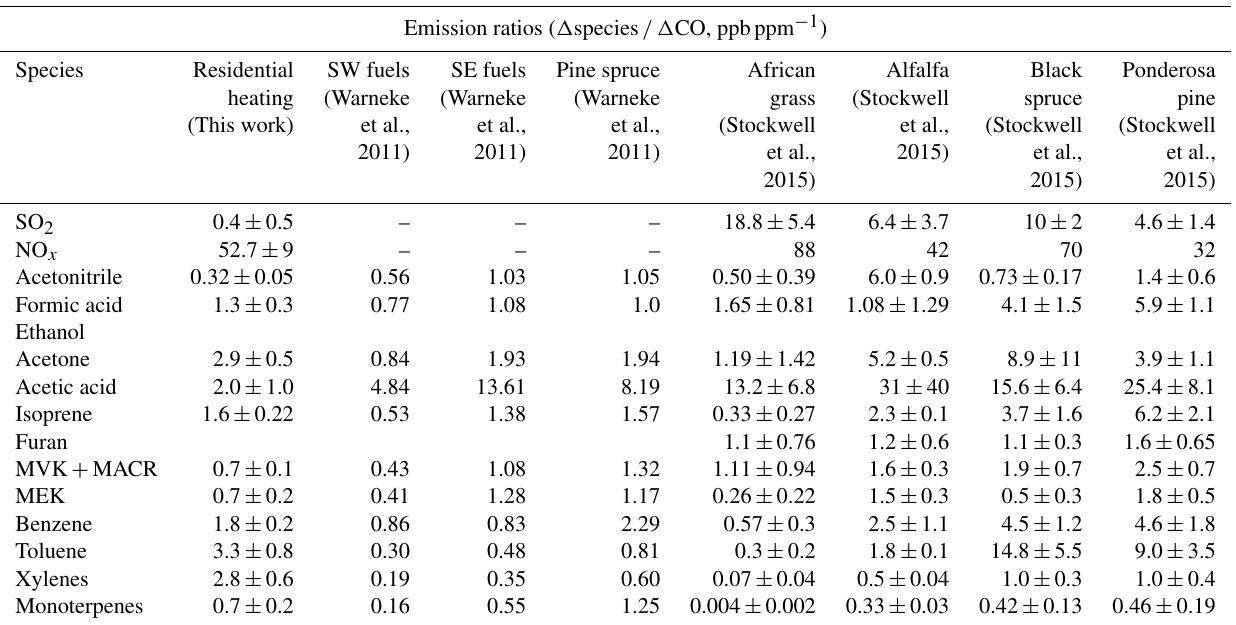
Table 5. Emission ratios for biomass burning due to residential heating. Comparison with reported emission ratios from various biomass fuel types.